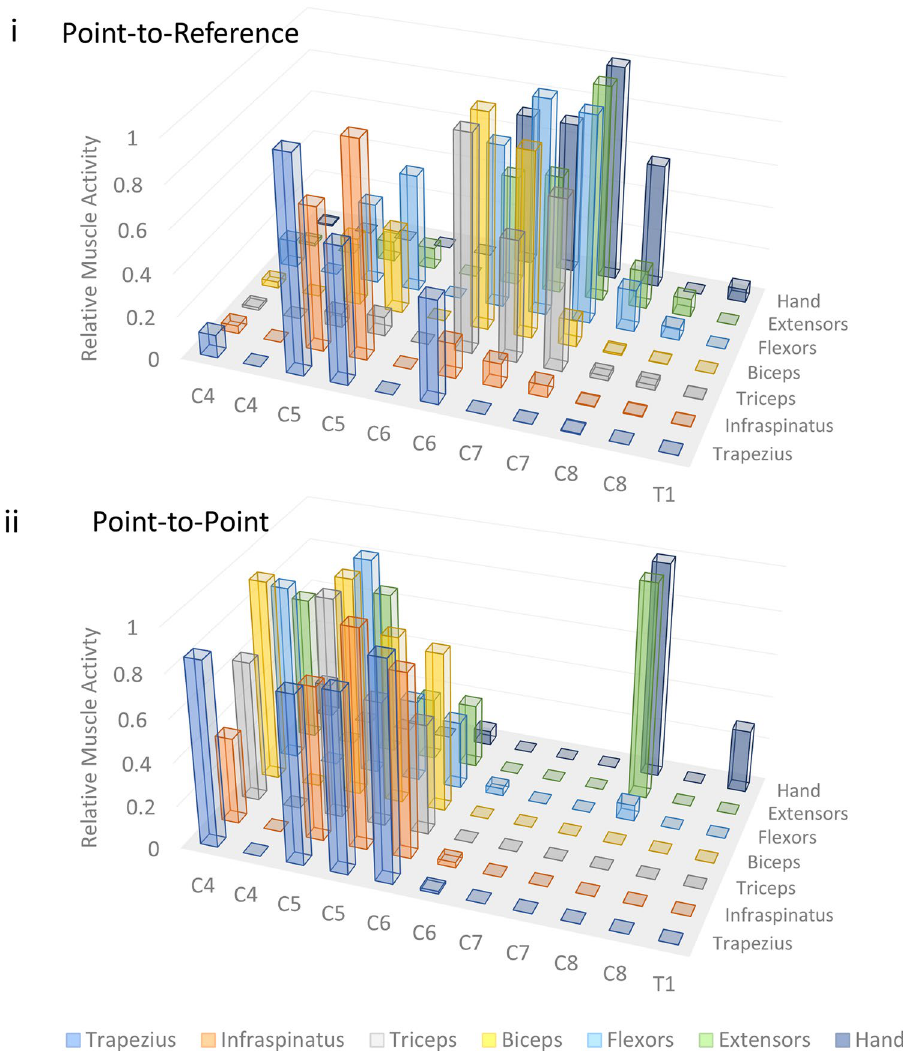
Figure 5. Point-to-reference and point-to-point mapping. The relative muscle activity was defined as the amplitude observed at a given level normalized to the maximal amplitude observed through an entire mapping session. The graph displays relative muscle activity at each spinal position using (i) point-to-reference and (ii) point-to-point stimulation modalities. *Measurements were collected at 1.5 mm increments so there are rostral and caudal measurements at each spinal segment except for T1 where there is a single rostral measurement. The difference in the distribution of activated muscles at each position reveals dramatically different responses at each spinal level using each